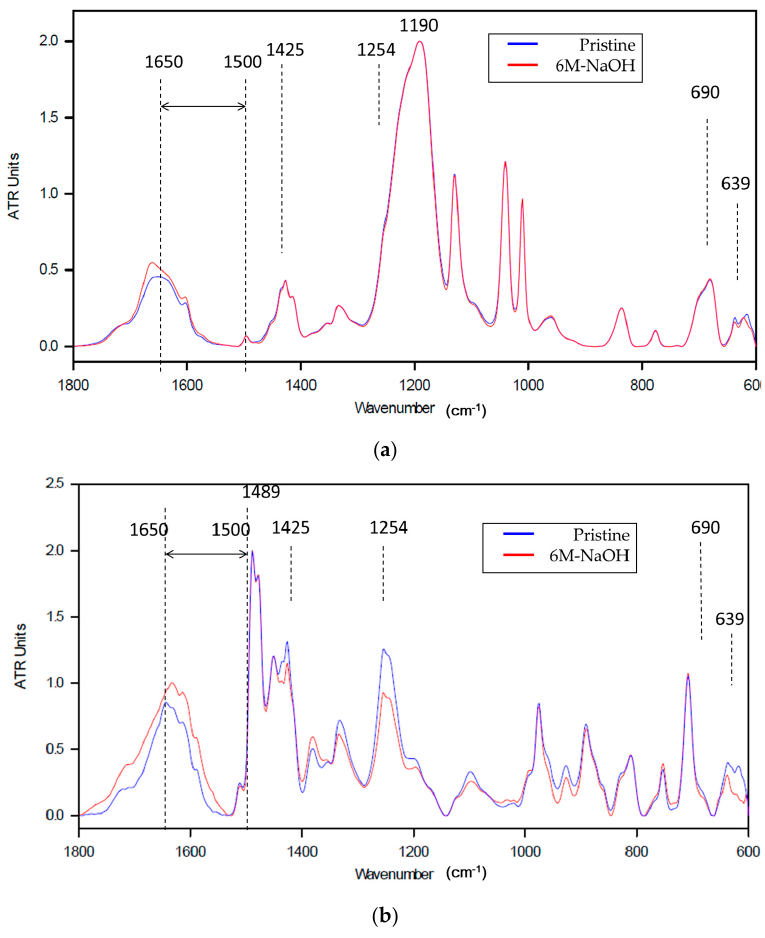
Figure 10. ATR-FTIR spectrum for ( a ) CMX and ( b ) AMX membranes before and after soaking in severe conditions (6 M NaOH solution for 168 h).